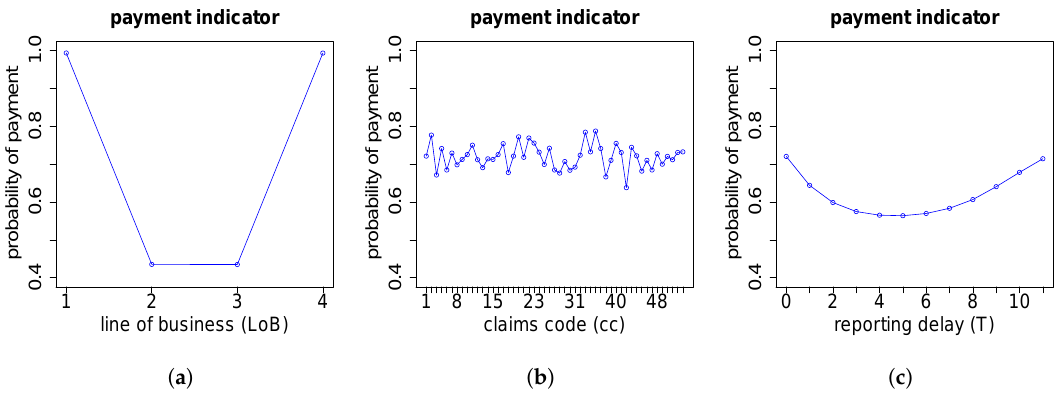
Figure A6. Payment indicator Z w.r.t. the features ( a ) LoB ; ( b ) cc and ( c ) reporting delay T